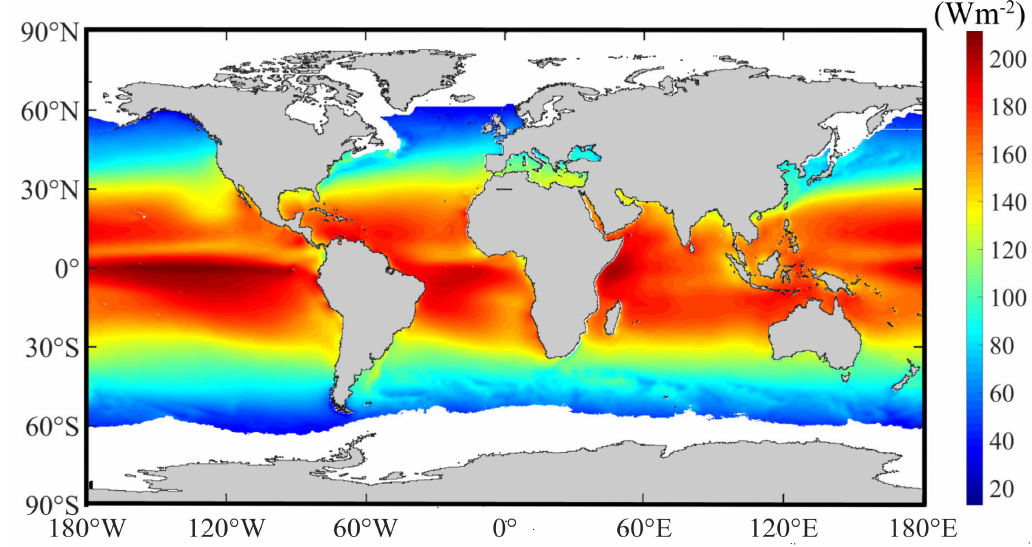
Figure 3. Multiannual mean J-OFURO3 sea-surface R n values during the period from 1988 to 2013.